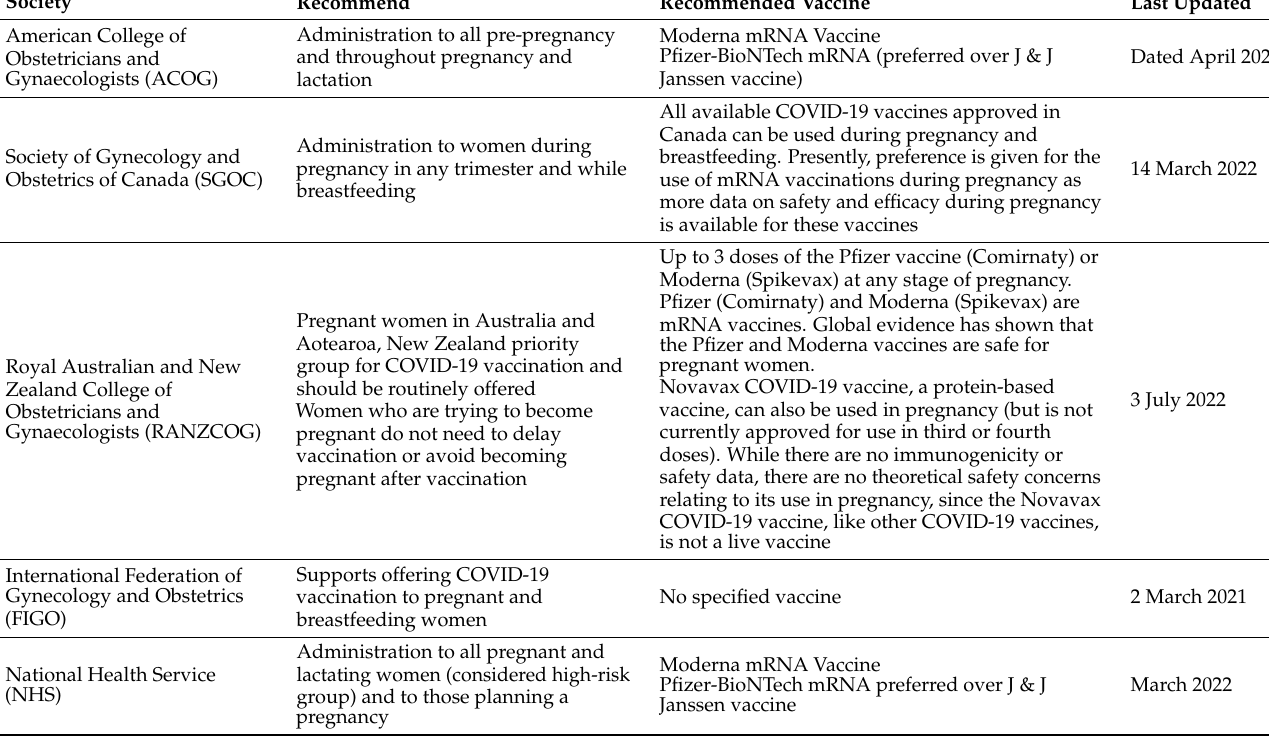
Table 4. Recommendations and positions of the various societies on COVID-19 vaccination in pregnancy and